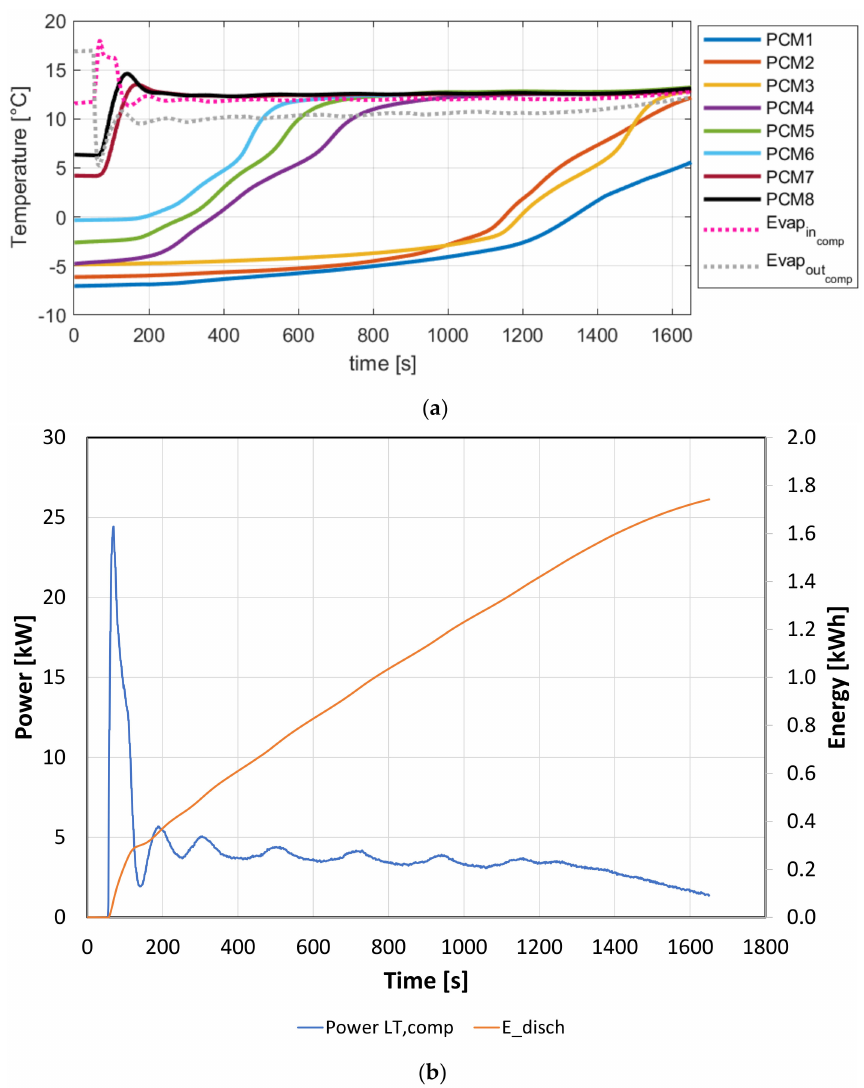
Figure 6. Example of test results for cooling mode 3. ( a ) Temperatures of HTF and the PCM; ( b ) energy discharged during the test and correspondent